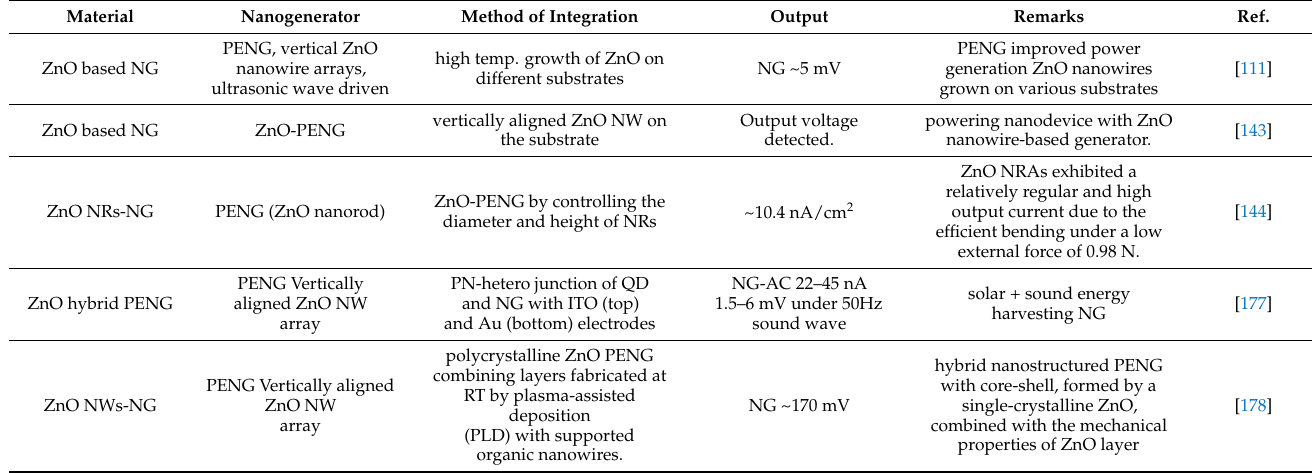
Table 5. Summary of ZnO-PENG method of fabrication and integration for different